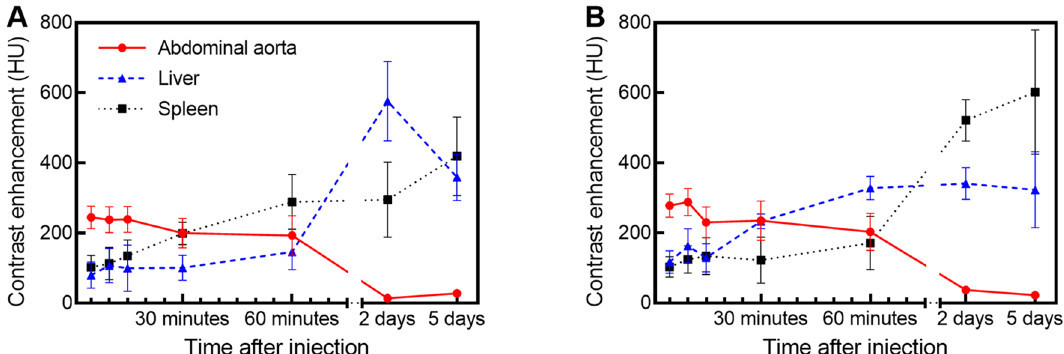
Figure 5. Contrast enhancement in the organs of mice that were injected with ( A ) PPEG 2000 -GdNP and ( B ) PPEG 5000 -PPEG 1000 -GdNP displayed similar trends over time, where decreased attenuation in the vasculature was accompanied by increased attenuation in the liver and the